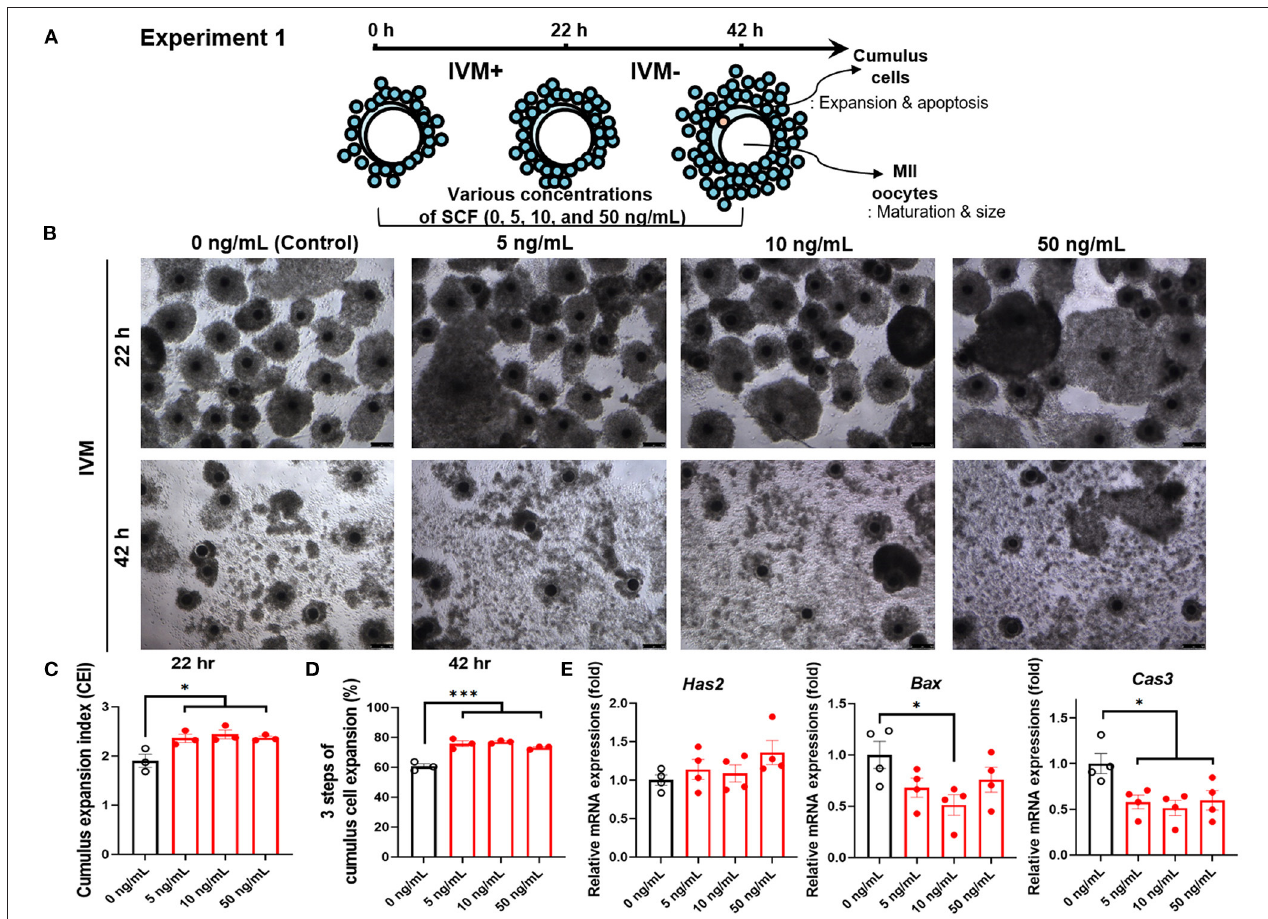
FIGURE 1 | Effect of stem cell factor (SCF) supplementation during in vitro maturation (IVM) on cumulus cell expansion of porcine cumulus-oocyte complexes (COCs). (A) Experimental design to determine the optimal concentrations of SCF for porcine oocyte maturation. IVM + and IVM– indicate that incubation was in media with or without the eCG hormone, respectively. (B) Representative morphologies of porcine COCs from each group after 22 or 42h of IVM supplemented with various concentrations of SCF. Scale bar = 100 µ m. (C) Quantified cumulus expansion index (CEI) after 22h of IVM supplemented with various concentrations of SCF. (D) Quantified three steps of cumulus cell expansion after 42h of IVM supplemented with various concentrations of SCF. (E) The mRNA expression levels of the genes Has2 , related to cumulus cell expansion, Bax , and Caspase 3 ( Cas3 ), related to apoptosis, were compared between cumulus cells from various SCF-treated groups. For all graphs, the value represents the mean ± SEM. Asterisks indicate statistical significance (* p < 0.05 and *** p < 0.001). Statistical significance was determined by one-way ANOVA. The experiments were repeated four